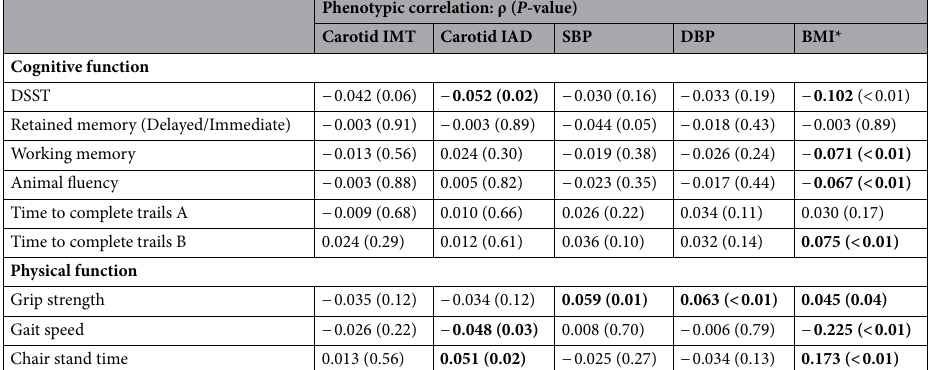
between lower physical function and adverse CVD risk factors. The significant pleiotropic results suggest that CVD is not only a risk factor for cognitive and physical decline, but may also be partially driven by the same genes and have a shared pathology. The relationship between BMI and physical function is known to differ by age, such that a greater BMI in early to middle adulthood is associated with an increased risk of chronic disease and mortality 37 , but in geriatric populations, greater BMI is associated with reduced frailty and a lower risk of morbidity and mortality 38 . Not only does obesity in early to middle adulthood appear to increase mortality risk, but it also prompts declines in physical function and may even lead to overt frailty and it subsequent outcomes 39,40 . In our study, both gait speed and chair stand time were genetically and phenotypically correlated with obesity (e.g., BMI, waist circumference), but not cardiovascular measures (e.g., IAD, IMT, SBP, DBP). This relationship is consistent and expands upon previous phenotypic correlation studies of obesity and frailty. In addition to its shared genetic variance with physical function, we also found that BMI shares genetic variance with some measures of cognitive function. All of the cognitive measures that were genetically cor- related with BMI approximate frontal lobe function, an area of the brain that is responsible for actions such as executive functioning and is susceptible to the detrimental effects of aging 41,42 . These novel findings should